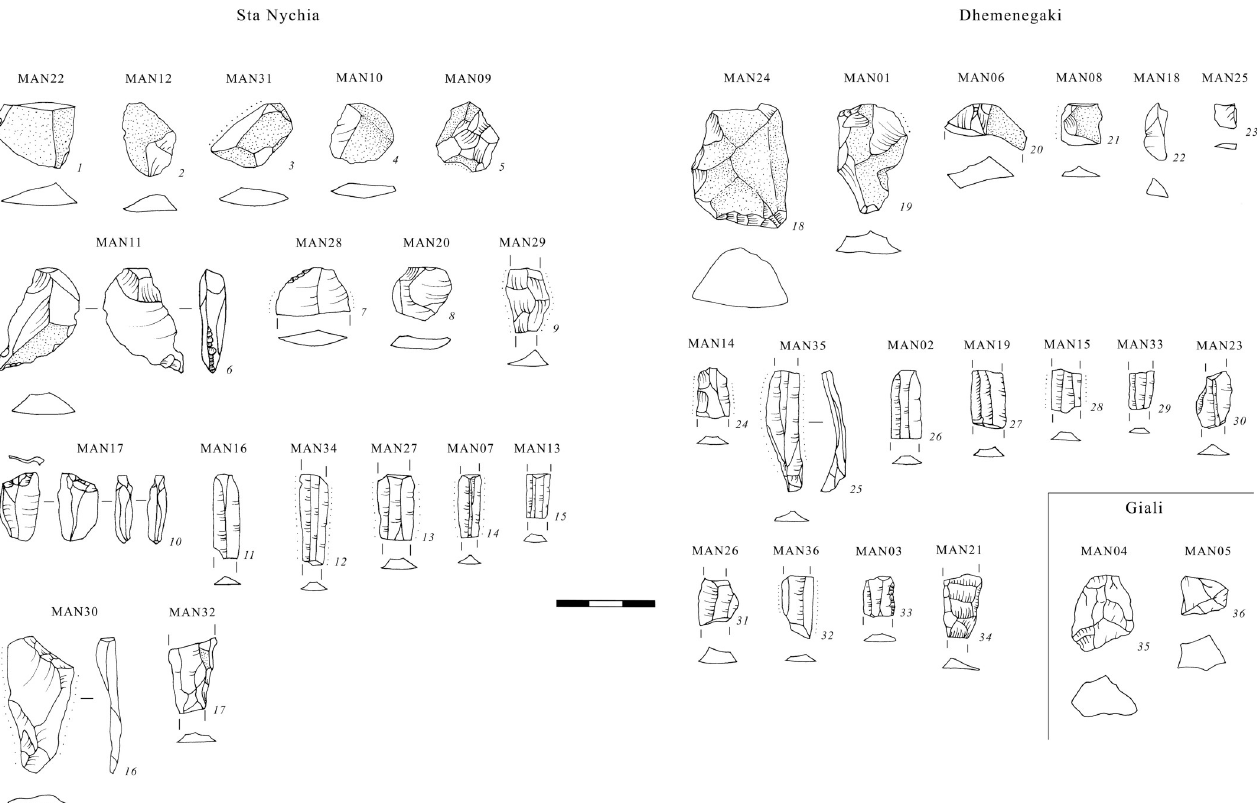
Fig 9. Artifacts of obsidian sourced to Sta Nychia, Dhemenegaki (Melos), and Giali A. All cross-sections drawn at midpoint; Labriola, L., Mili ć , M. Original copyright with the authors.